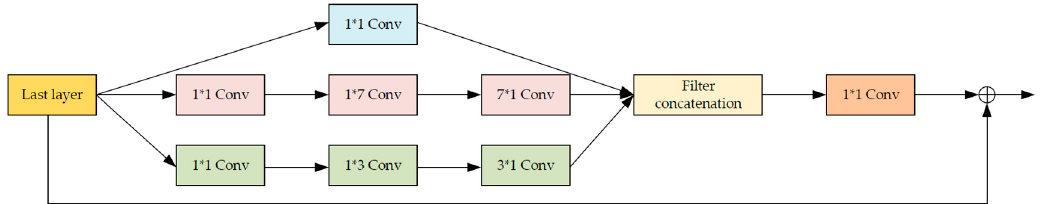
Figure 3. The inception-residual block used in the proposed network.